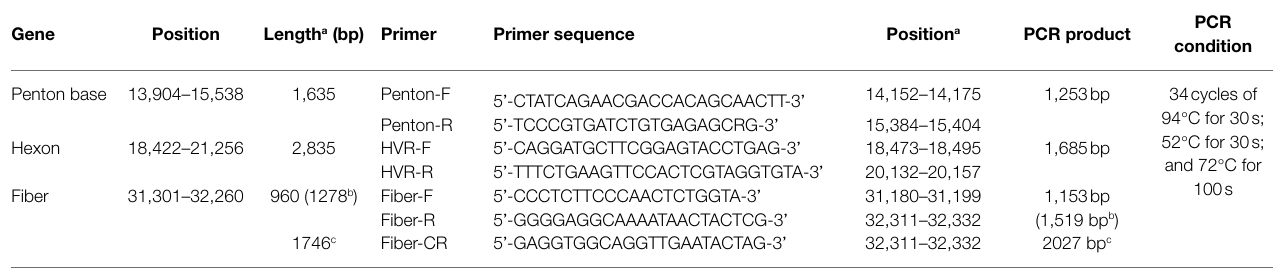
TABLE 1 | Universal primers for the detection, typing, and sequencing of